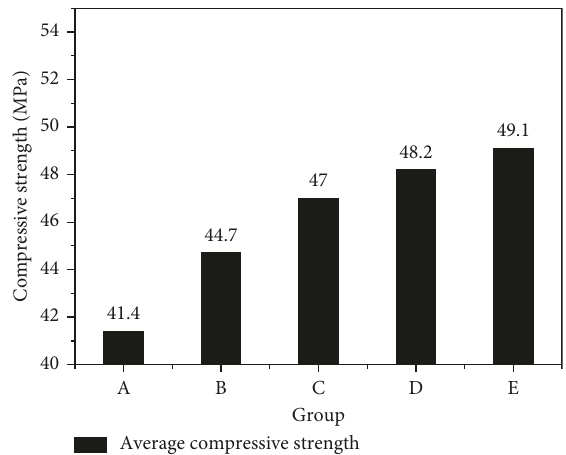
Figure 4: The compressive strength of steel slag core concrete with different shell thicknesses.